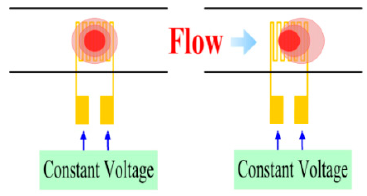
Figure 4. Sensing principle of micro flow sensor.